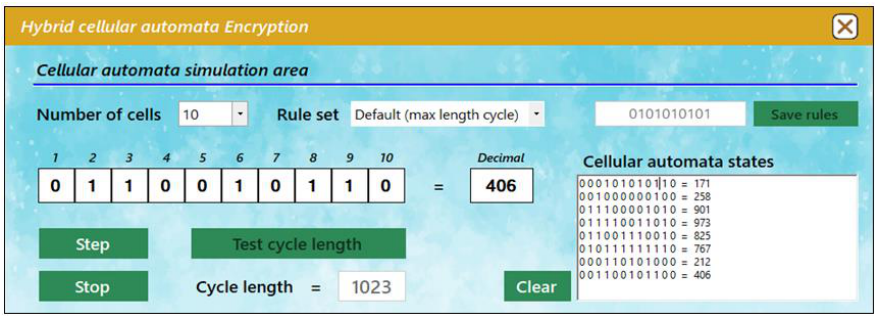
Figure 4. Application LHCA simulation area.